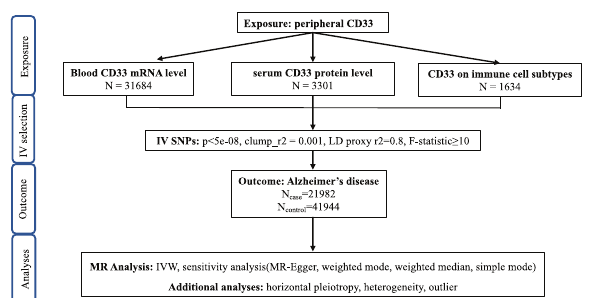
Fig. 1 Flow diagram of the process for the bidirectional 2-sample Mendelian Randomization (MR) analysis. IV instrumental variables; SNP single nucleotide